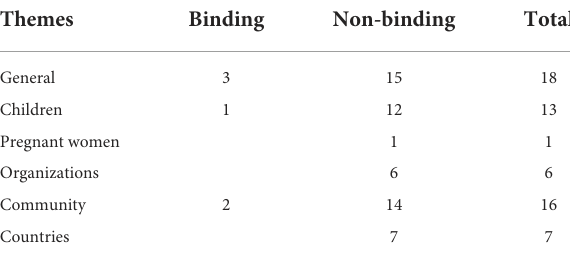
TABLE 2 Target groups of legislations, by the type of legislation. TABLE 3 Functional categories of legislations, by the type of